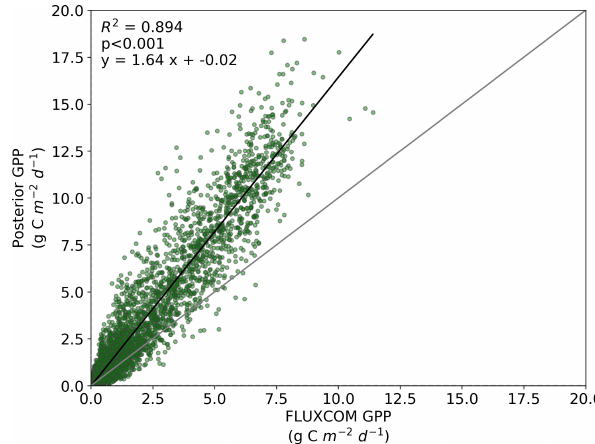
Figure B2. Comparison between FLUXCOM GPP and BETHY-SCOPE posterior GPP over continental North America (between 24 and 56 ◦